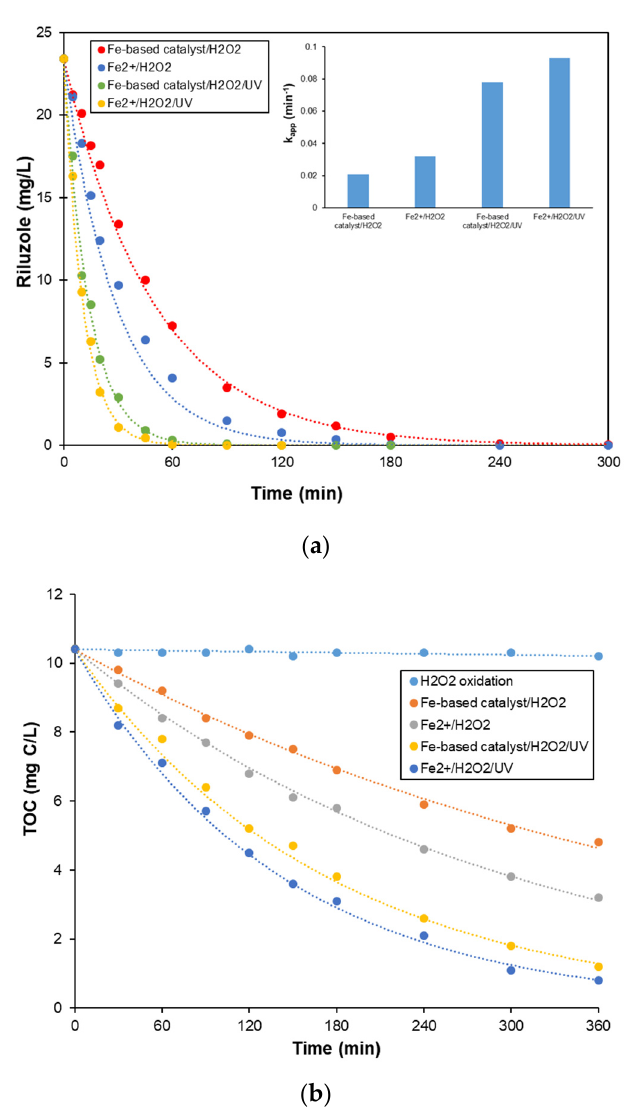
Figure 6. Effect of UV irradiation on the changes of ( a ) riluzole concentration, and ( b ) TOC content during the treatment of 23.4 mg/L riluzole aqueous solutions by homogeneous and heterogeneous Fenton and photo-assisted Fenton systems. Experimental conditions: H 2 O 2 : 1000 mg/L, Fe-based catalyst: 200 mg/L (particle size < 200 µm), Fe 2+ : 140 mg/L, UV irradiation: Medium mercury pressure lamp (Light wavelength range: 200–600 nm, power input: 150 W), pH = 3.0, Temperature: 23–25 °C, Mixing rate: 400 rpm.